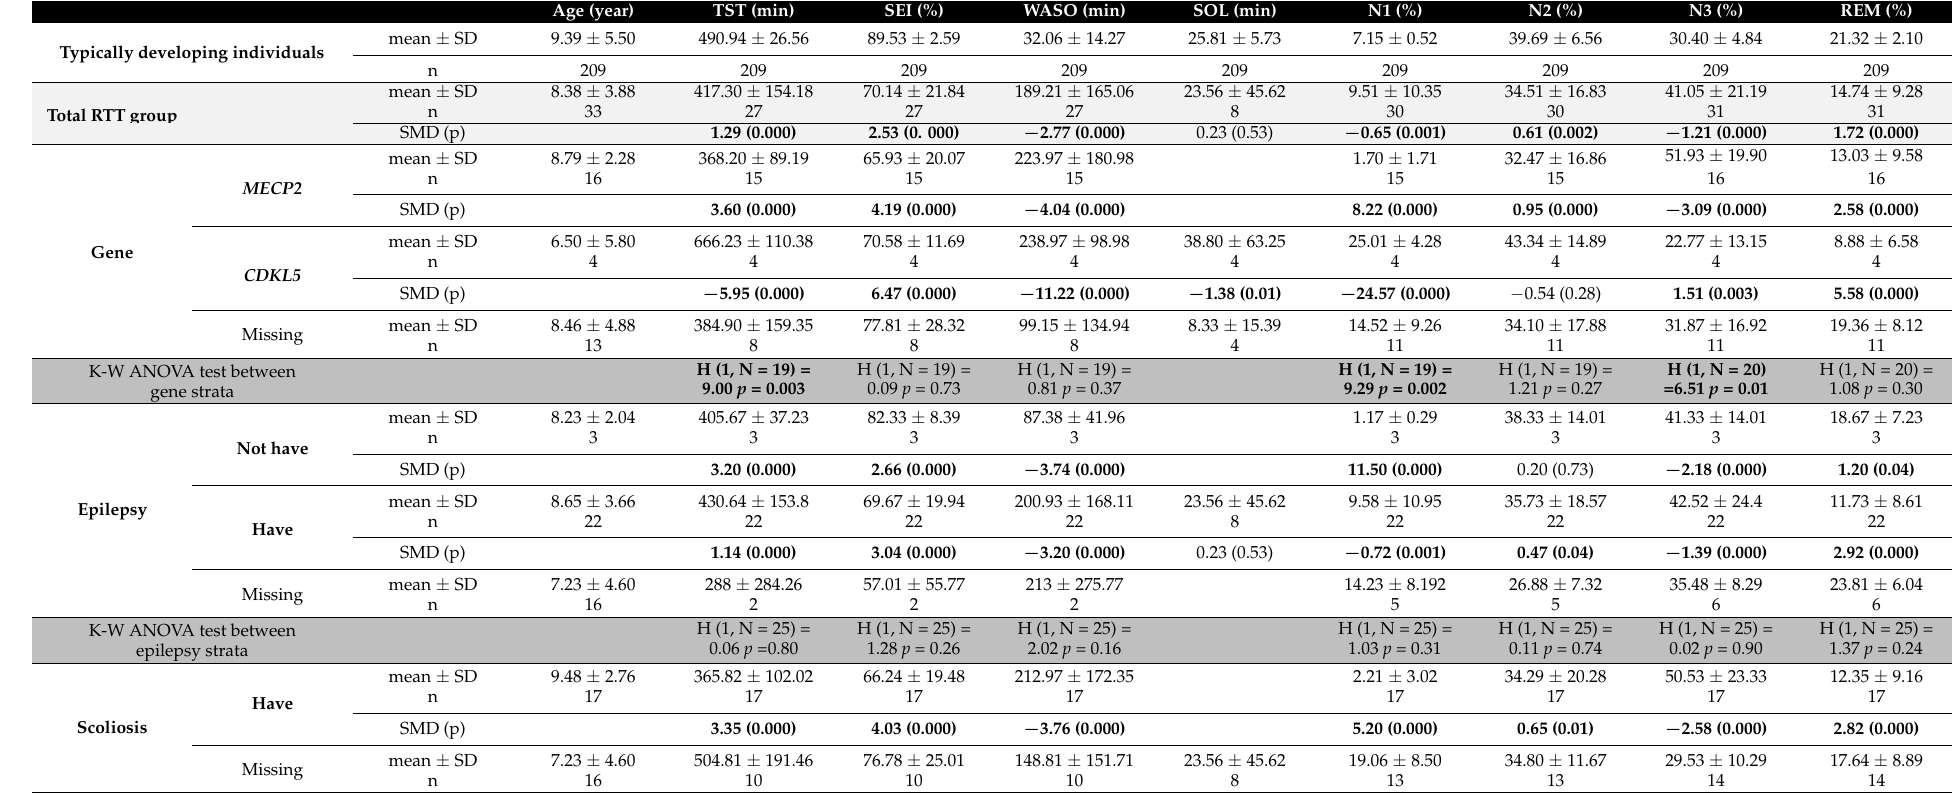
Table 2. Summary of strata